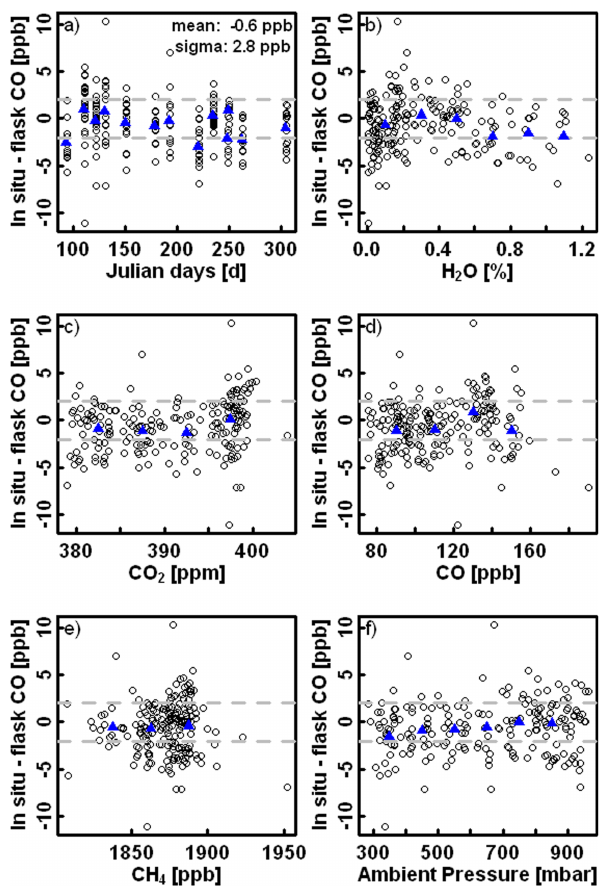
Fig. 8. Comparisons of in situ and flask measurements of CO made by NOAA/ESRL on board an aircraft in Alaska in 2011. (a) The time series of the differences between integrated in situ measure- ments and flask measurements, with the mean values of the binned biases in time (per flight); (b) – (f) the differences between in situ measurements and flask measurements plotted as a function of H 2 O, CO 2 , CO, CH 4 , and ambient pressure, with the mean val- ues of the binned biases in H 2 O (0.2% bin), CO 2 (5ppm bin), CO (20ppb bin), CH 4 ,(25ppb bin) and ambient pressure (100mbar bin) bands, shown in blue triangles. The WMO-recommended compati- bility of ± 2ppb is shown in each plot in grey dashed